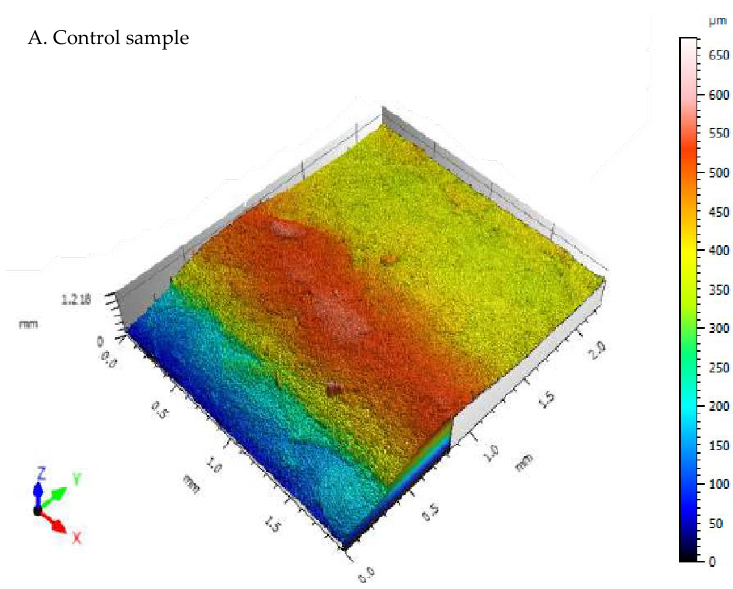
Figure 4. Sensory scores for spent grain pasta.